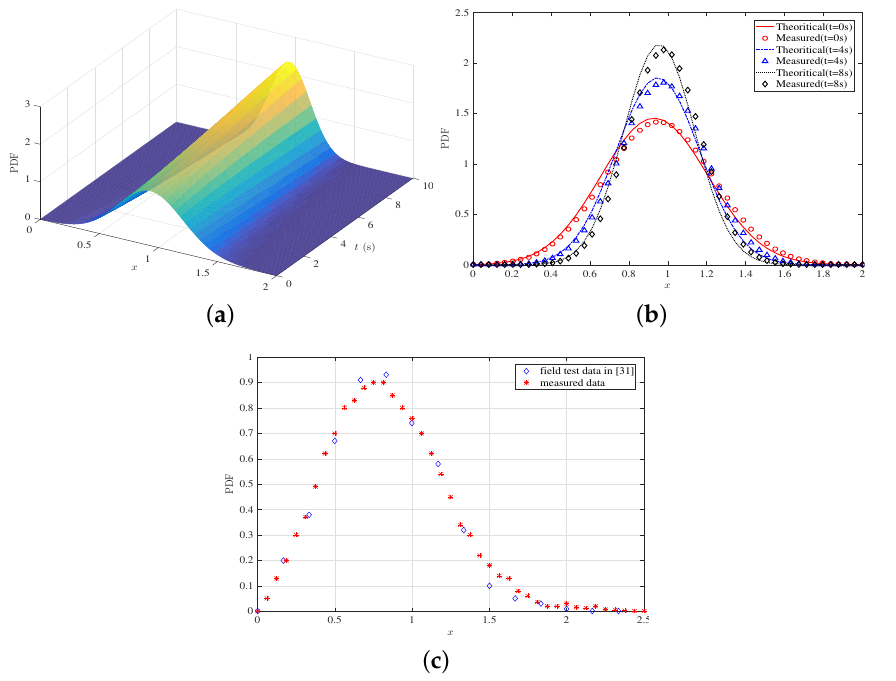
Figure 10. ( a ) The theoretical results of time-variant PDFs, ( b ) the measured time-variant PDFs of proposed emulator at different time instants, and ( c ) the measured PDF of proposed emulator and the PDF of field